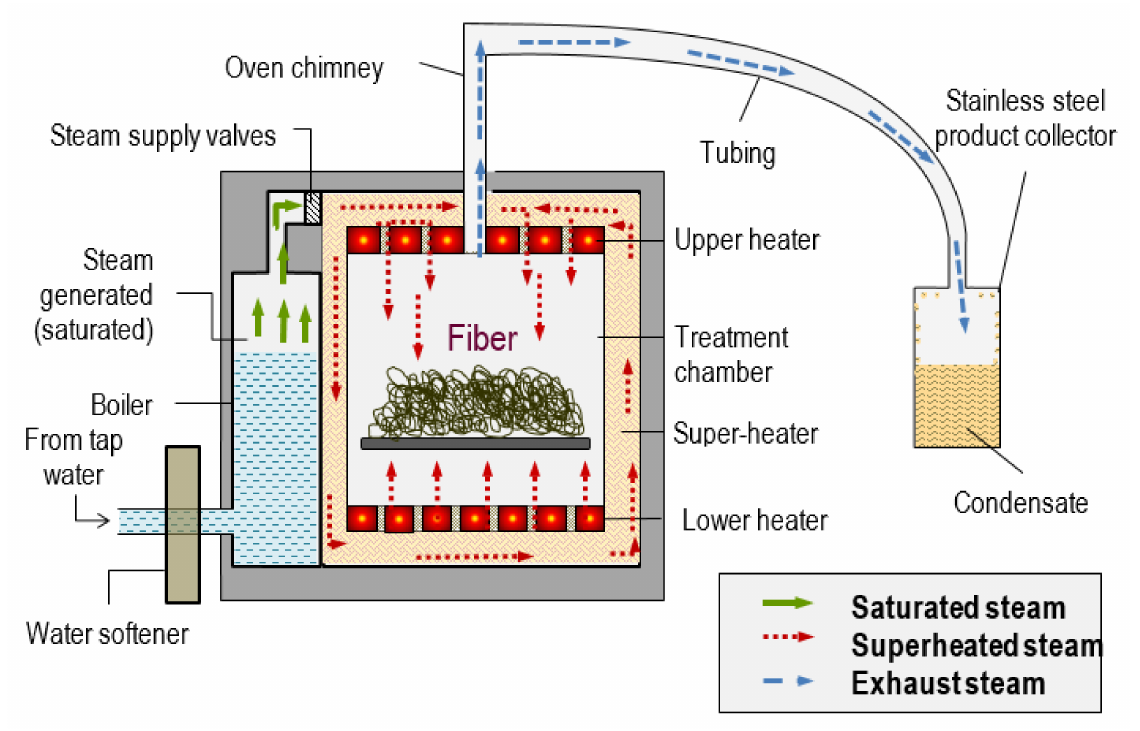
Figure 4. Schematic design of superheated steam pretreatment. Reprinted with permission from ref. [31]. 2018 Universiti Putra